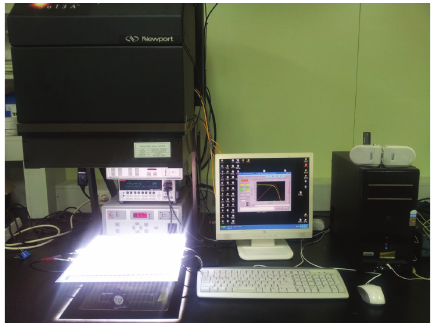
Figure 5: Solar simulator used for DSSC module and